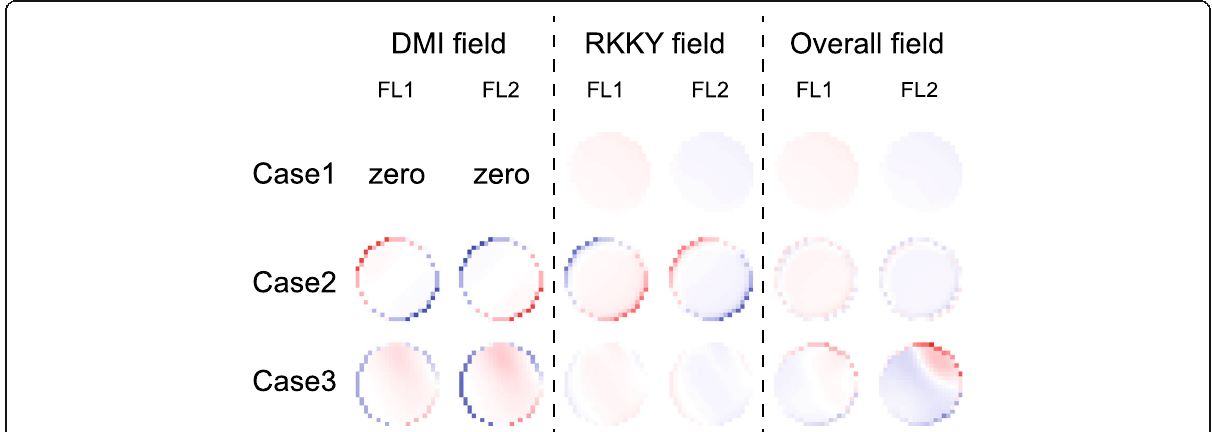
Fig. 6 Spatial distributions of the DMI and RKKY fields. Here a typical result at one time moment is shown for each case. The conclusion remains unchanged at the other time moments. Case 1: D 1 = D 2 =0. Case 2: D 1 =1.5 mJ/m 2 , D 2 = − 1 mJ/m 2 , i.e., DMI effect is canceled out. Case 3: D 1 = D 2 =1 mJ/m 2 , i.e., DMI